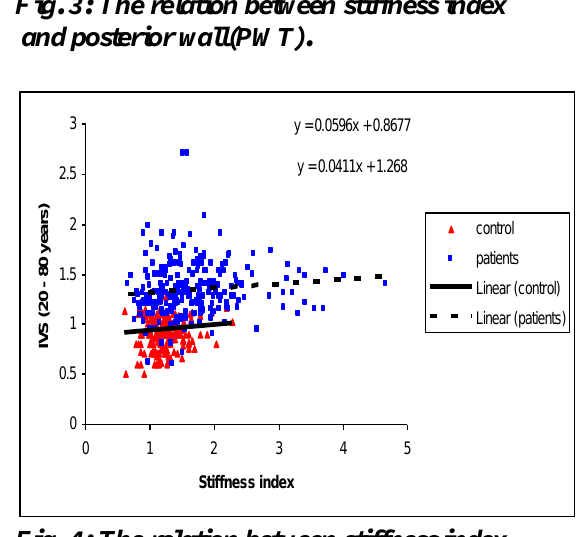
Fig. 4: The relation between stiffness index and interventricular septum(IVST).